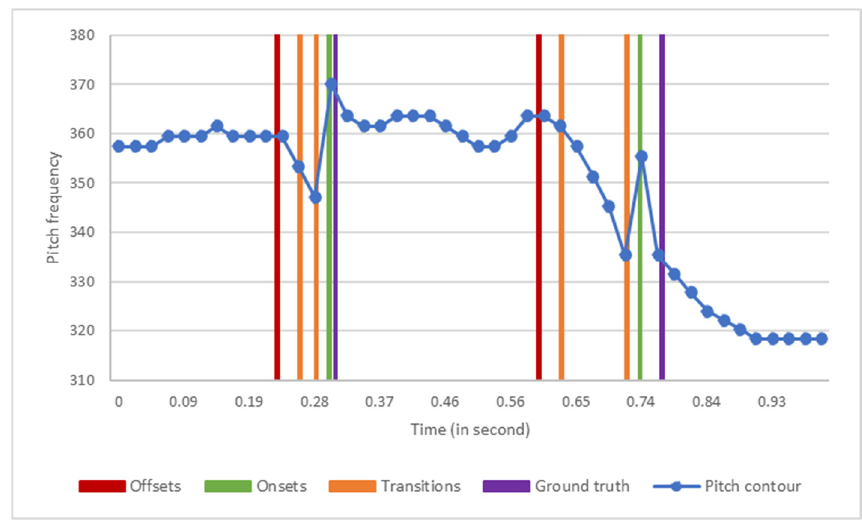
Figure 4. Points’ statuses on a pitch contour. There are three notes: F4, F4, and E4, in order, sung by a professional female singer. The average pitch frequencies of the notes are 359, 362, and 323 Hertz, respectively.